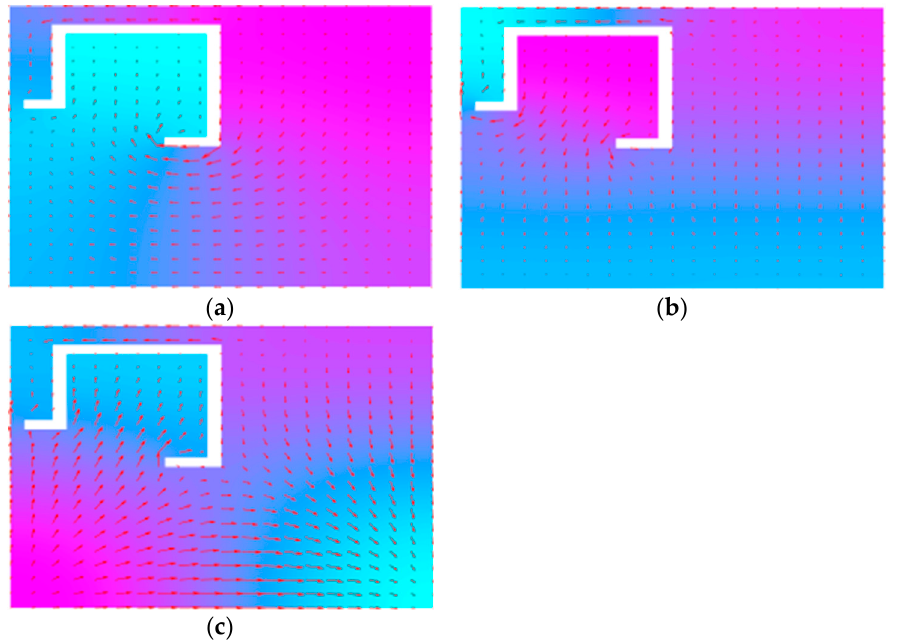
Figure 3. The lowest 3 modes of the G-slot antenna were computed by the finite-element method in the PDE tool in MATLAB.